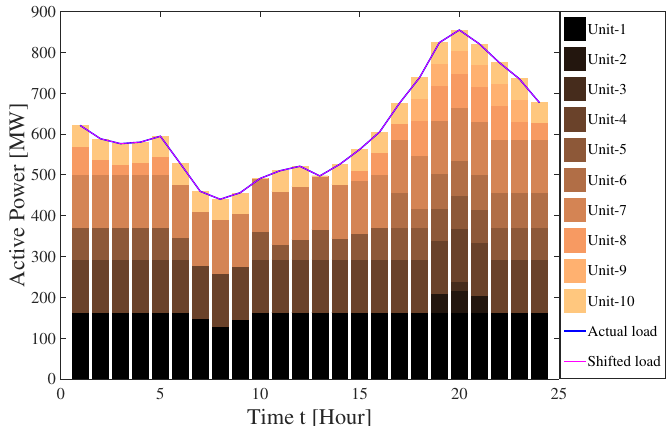
Figure 1. Unit commitment without considering ESS.